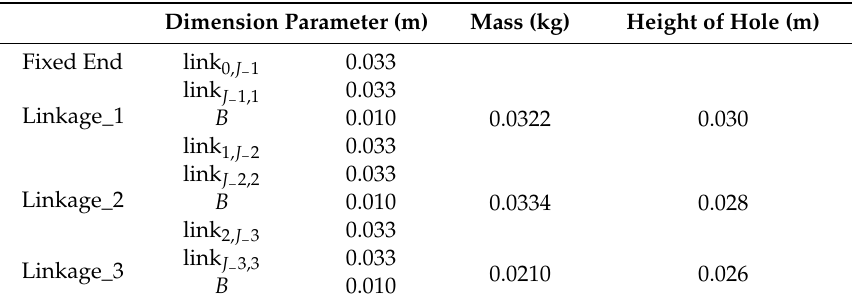
Table 1. Structure parameters of the 3-DOF planar